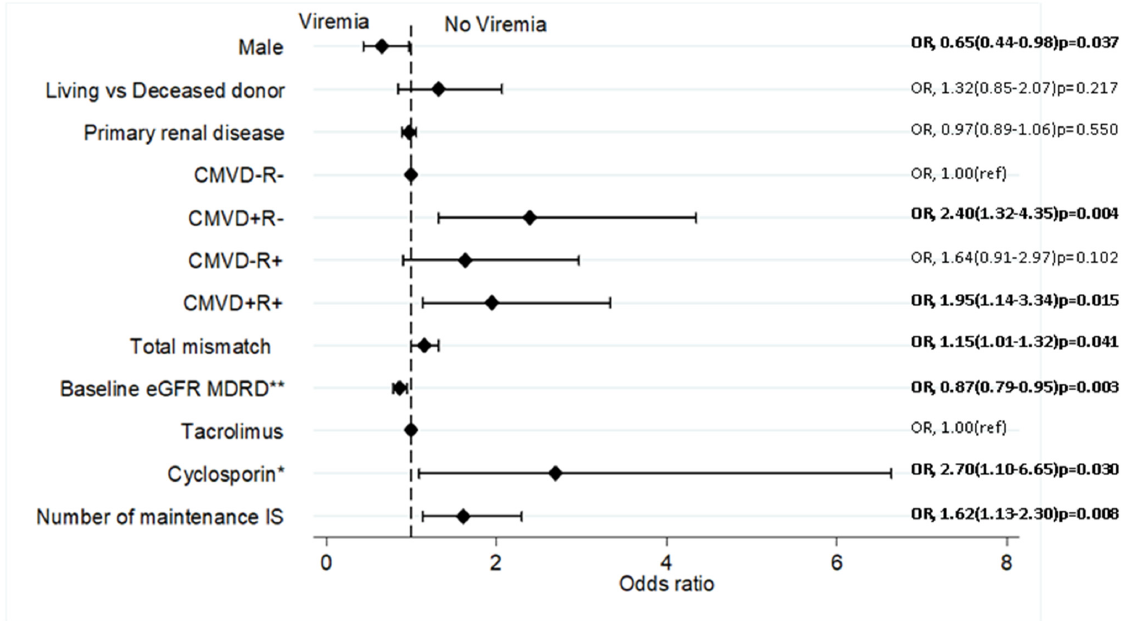
Figure 1. Impact of Donor and recipient CMV serostatus on incidence of CMV viremia. D, donor; R, recipient; +, positive; − , negative.